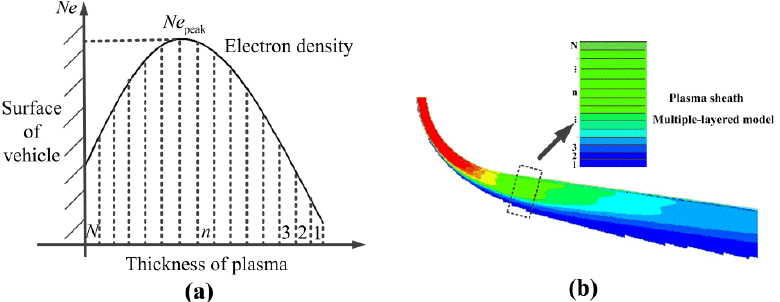
Figure 8. Schematic diagram of the electron density and the multiple-layered plasma sheath. ( a ) The bi-Gaussian distribution of the stratified plasma sheath’s electron density. ( b ) Schematic depiction of the plasma sheath with multiple layers at the local vehicle surface.